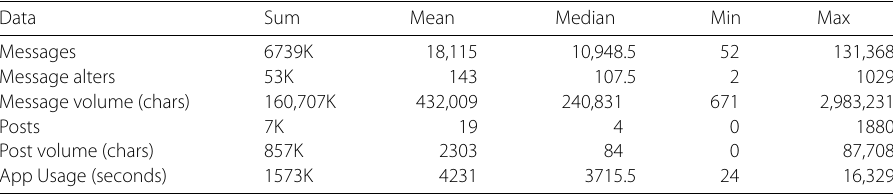
Table 3 Descriptive statistics for the textual and phone app usage features in the final dataset